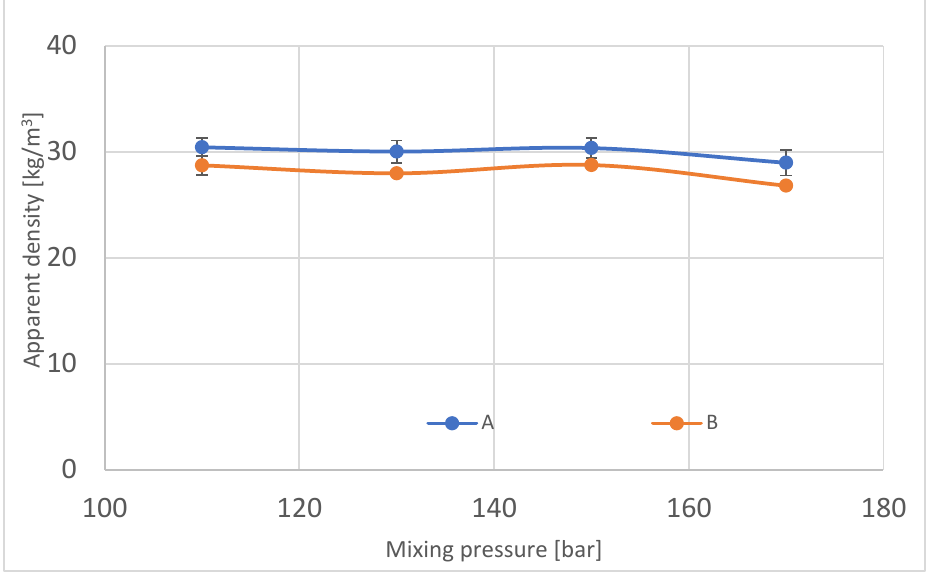
Figure 10. Apparent density in manufactured polyurethane blocks, broken down by pressure. Table 3. The differences of apparent density between localization in blocks.